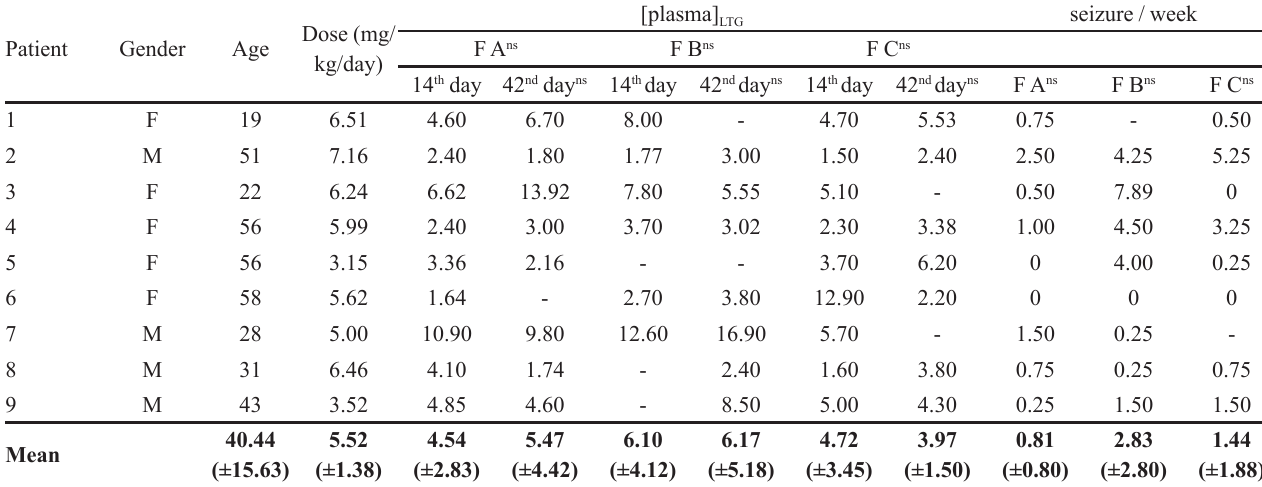
TABLE V - Gender, age, dose, plasma concentration and seizure/week for formulations A, B and C of lamotrigine